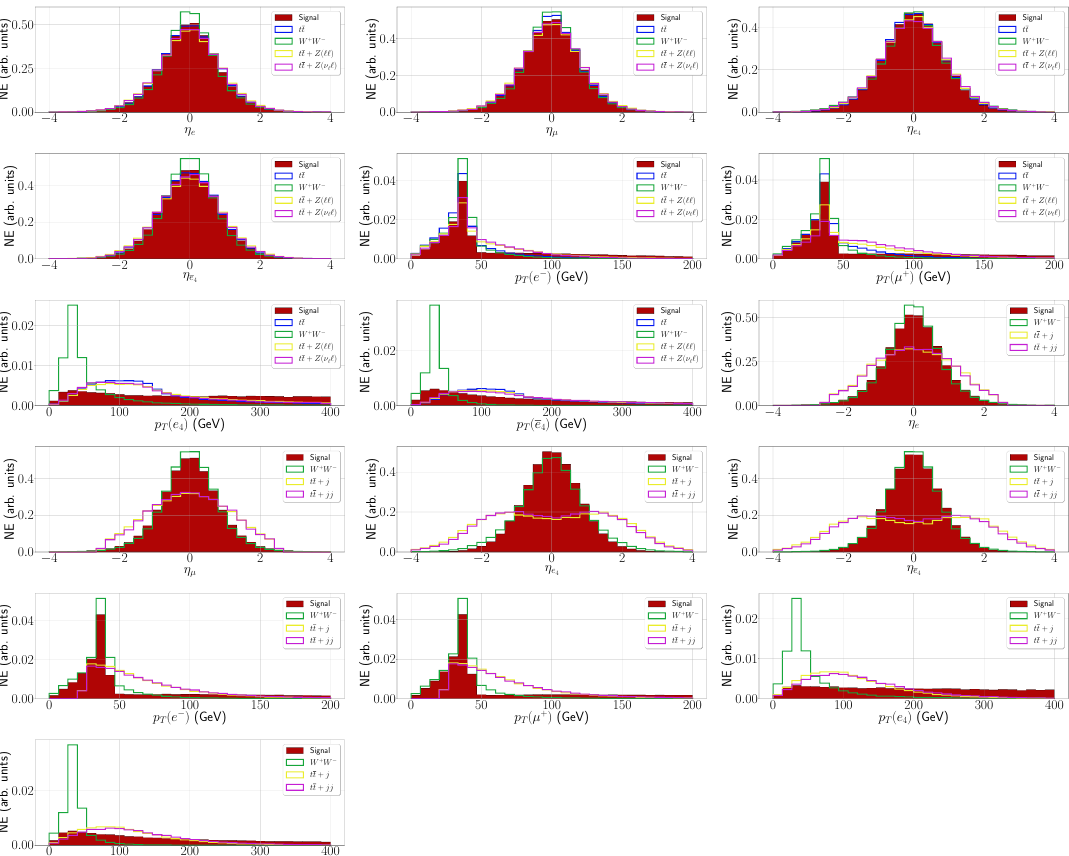
Figure 23. Dimensionless (angular) and dimension-full (kinematic) observables at the W ± reference frame for VBF and ZA channels (solid red) where it is considered 30 bins for all histograms. VBF channel correspond to plots with 3 distinct backgrounds, while ZA has 4. The same backgrounds from previous plots also applies here. From top left to bottom right, for both channels, we have distributions for pseudo-rapidity for e − , µ + , e for e − , µ + , e and ¯ e . Note that ν is the reconstructed missing energy vector, according to the 4 4 discussion in section